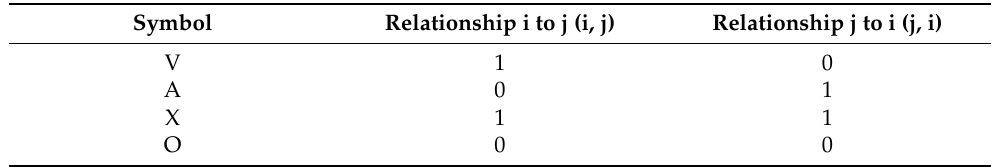
Table 4. Reachability Matrix (RM) relationship symbol. Symbol Relationship i to j (i, j) Relationship j to i (j, i)